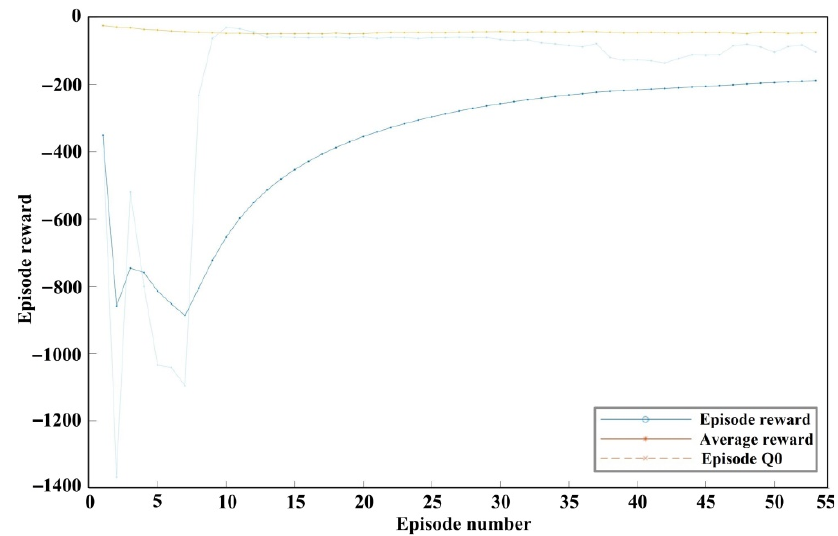
Figure 16. The training stage of the RL-TD3 agent for the correction of the u dref , u qref and i dref com-